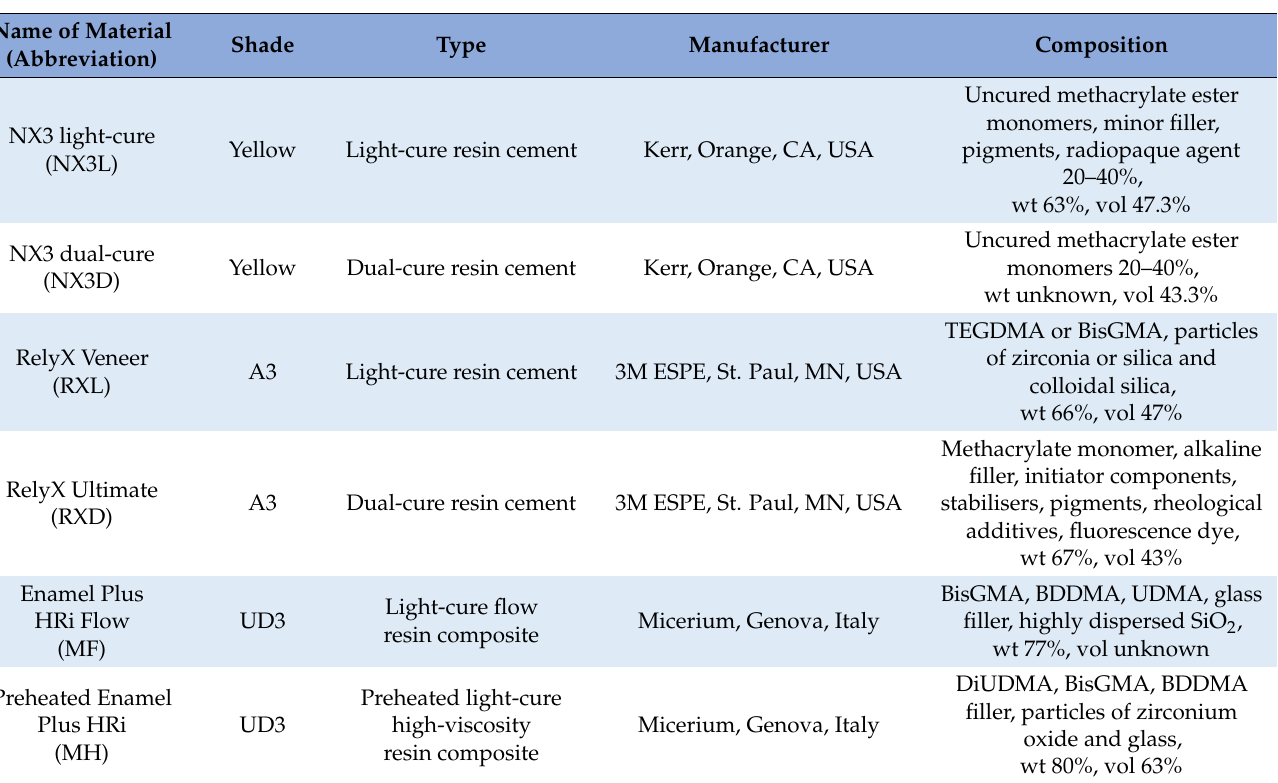
Table 1. Materials used in this